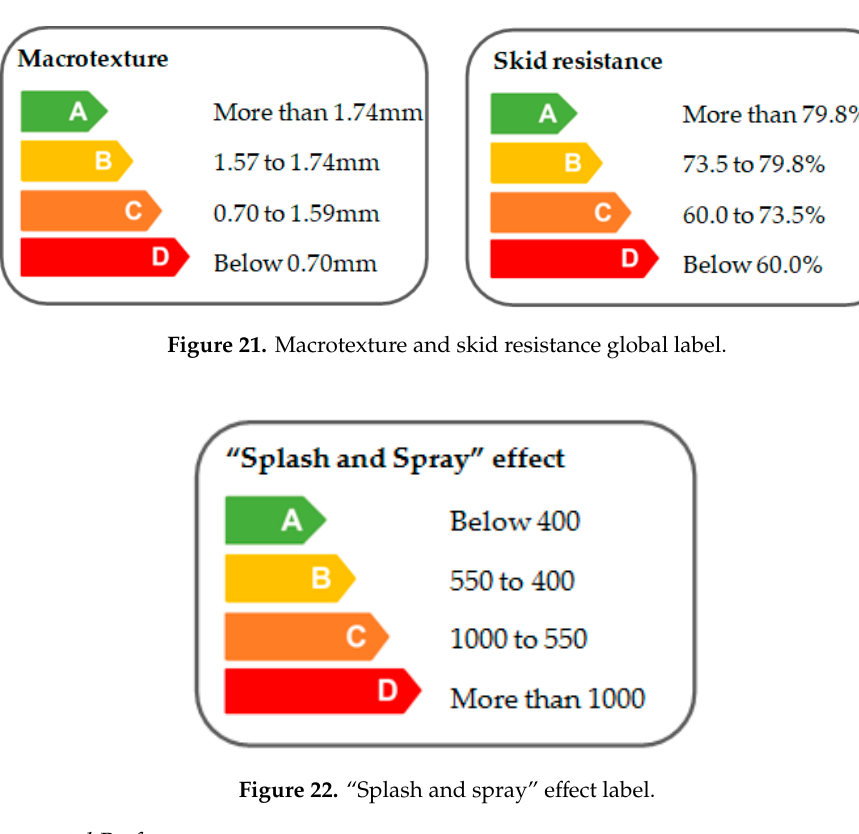
Figure 22. “Splash and spray” effect label.